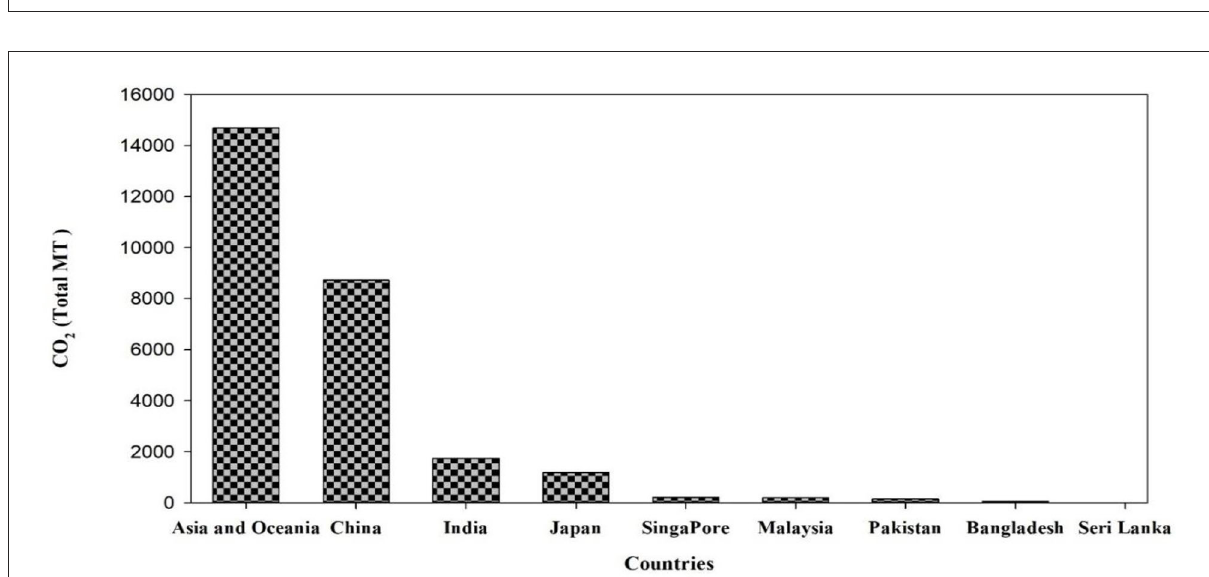
FIGURE2 Carbon dioxide (CO 2 ) emission from different Asian countries (source: International Energy Statistics https://cdiac.ess-dive.lbl.gov/home.html; Carbon Dioxide Information Analysis Center, Environmental Sciences Division, Oak Ridge National Laboratory, Tennessee, United